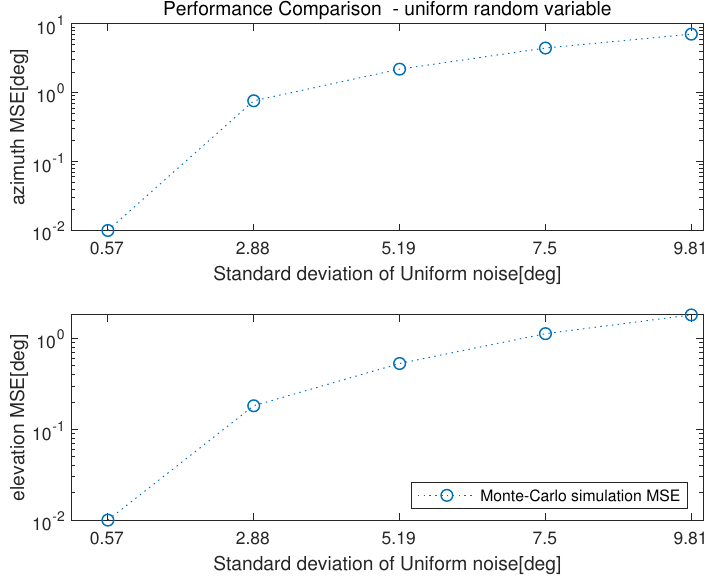
Figure 13. Performance for uniformly − distributed phase measurement error with θ ( 0 ) = 120 ◦ and ψ ( 0 ) = 75 ◦ . This figure shows the MSEs of azimuth and elevation with respect to phase error at a signal with low incident elevation by monte-carlo simulation(rectangular planar